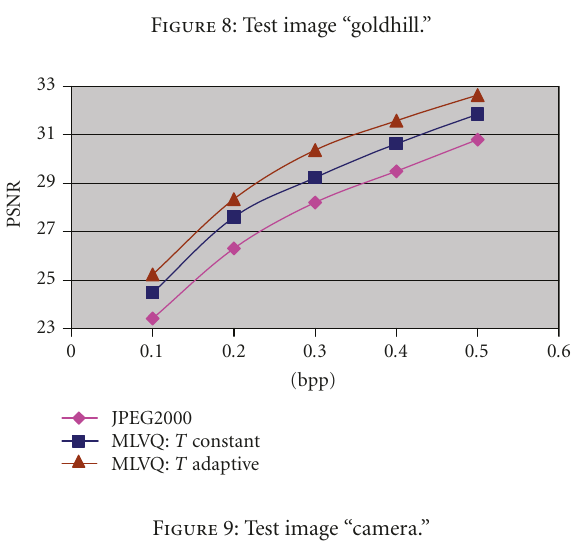
Figure 10: Test image “lena.”